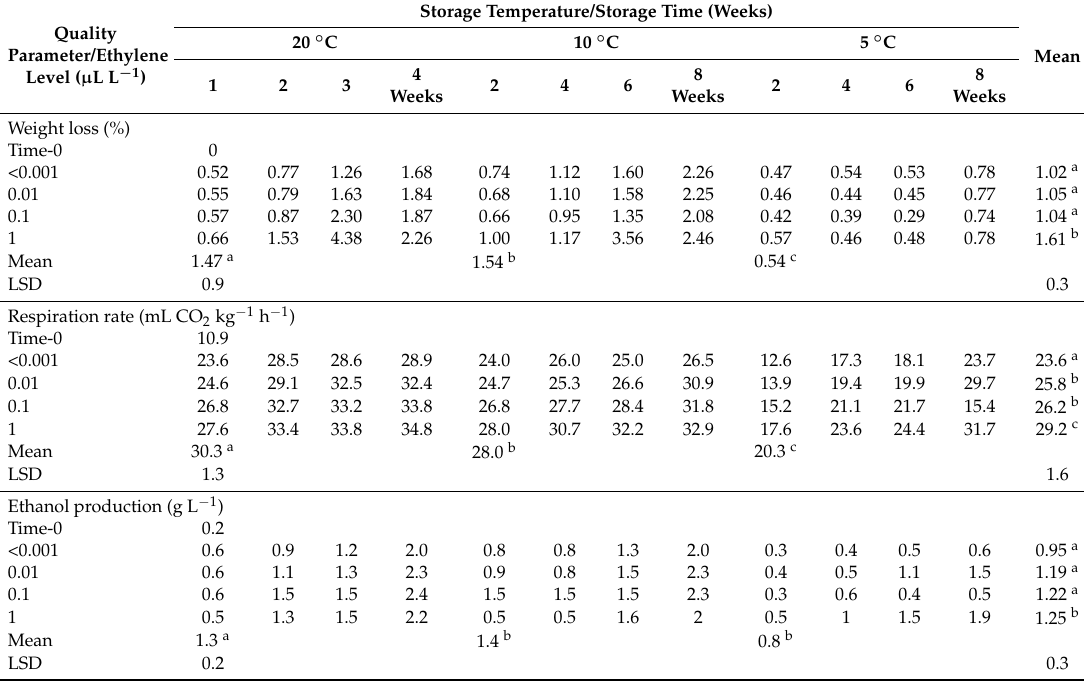
Table 4. Weight loss, respiration rate and ethanol accumulation in ‘Afourer’ mandarins as exposed to different ethylene concentrations and stored at 20, 10 and 5 ◦